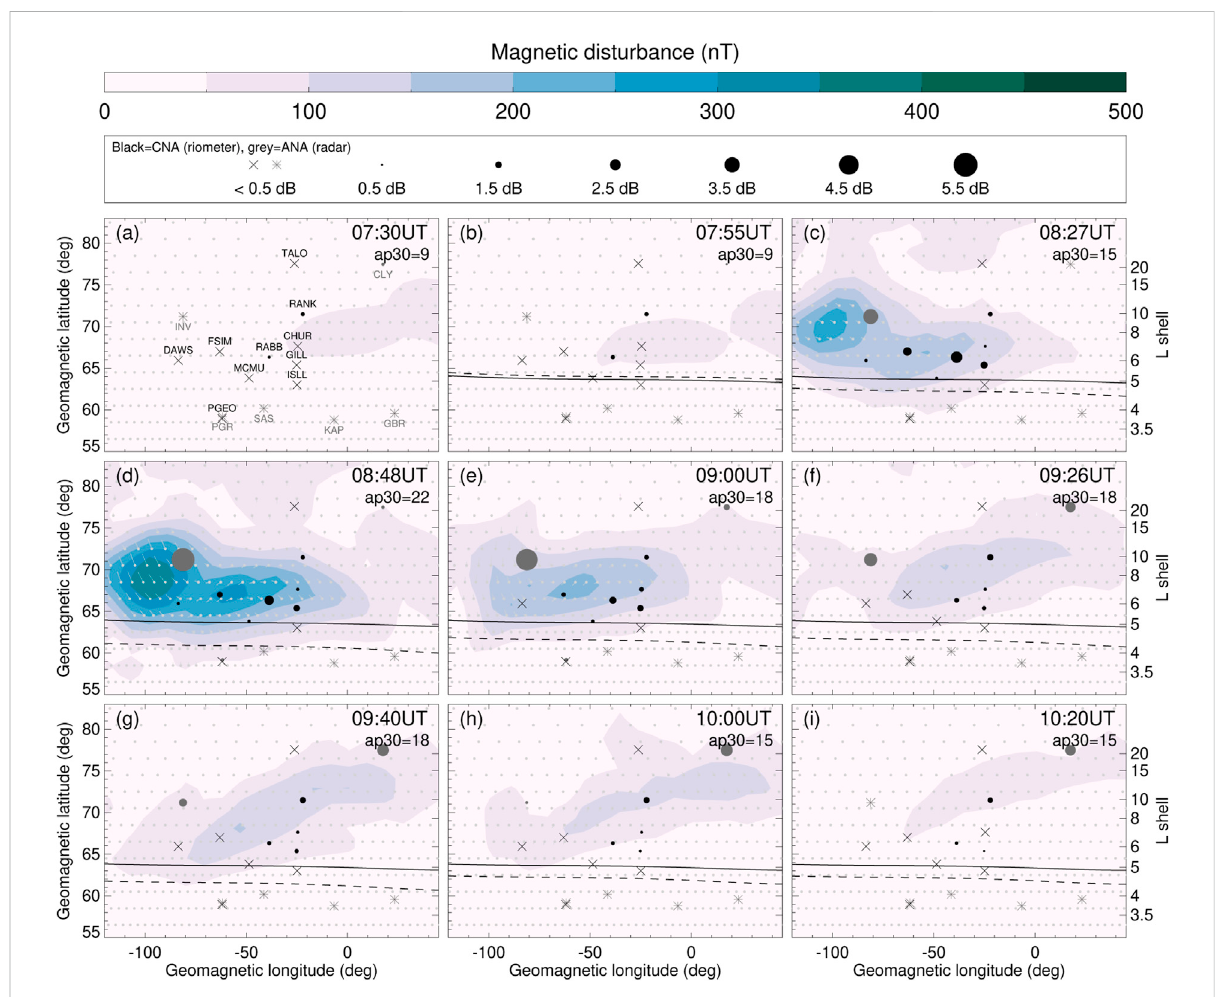
FIGURE 10 Spatial evolution ofthemagnetic fi eld disturbance,30 MHz cosmic noise absorption and 10 – 11 MHz atmosphericnoise attenuationduring the substorm event on 10 December